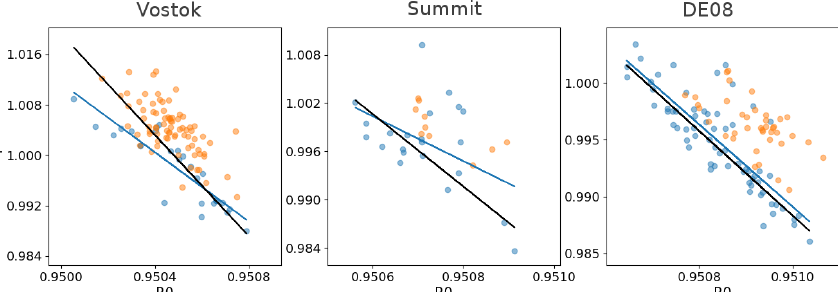
Figure 1. In each panel, the blue dots are the correcting factors α computed for low-density firn as a function of the preceding R 0 , the orange dots are the correcting factors α computed for high-density firn as a function of R 0 , the black line is the linear relation originally derived by J.-M. Barnola, and the blue line is the linear regression based solely on the low-density α .